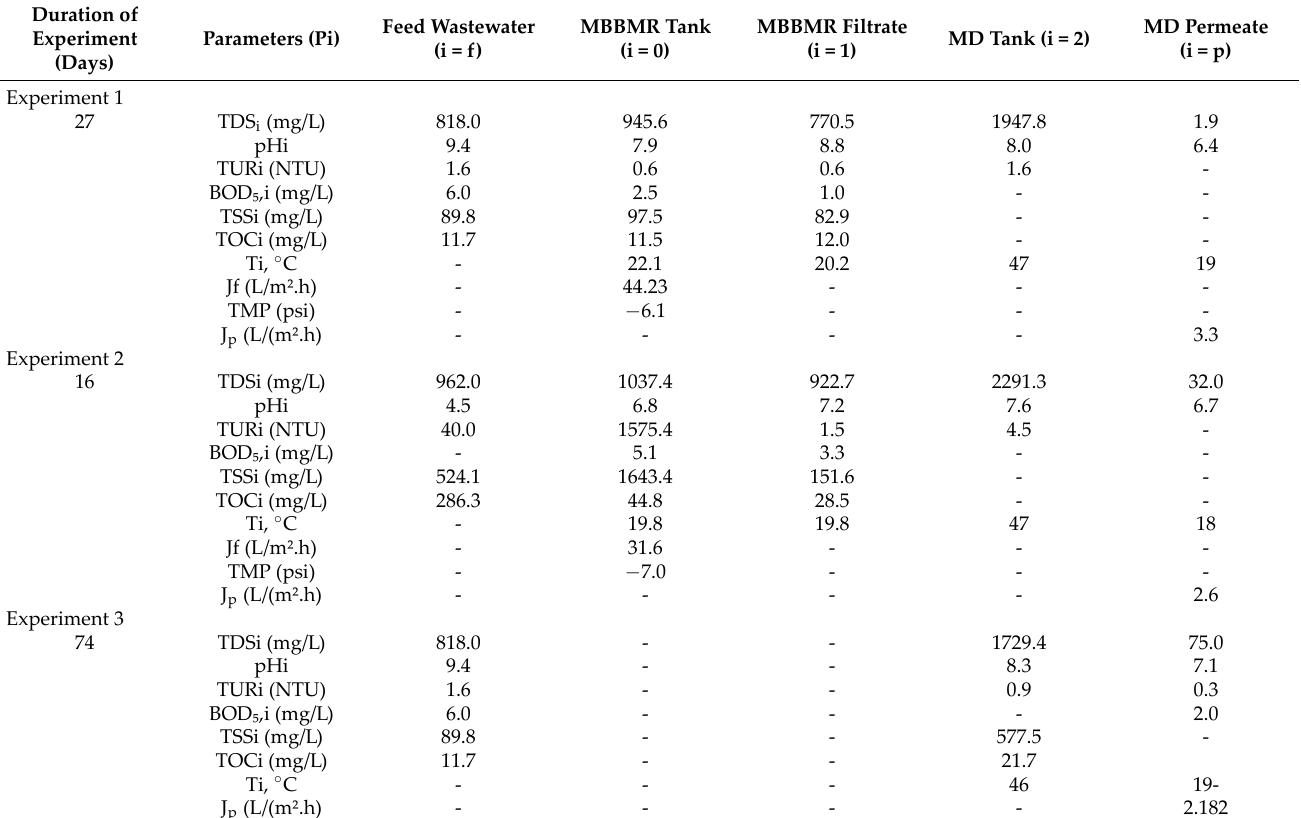
Table 3. Summary of experimental results indicating averages of performance parameters of the proposed configurations for industrial wastewater